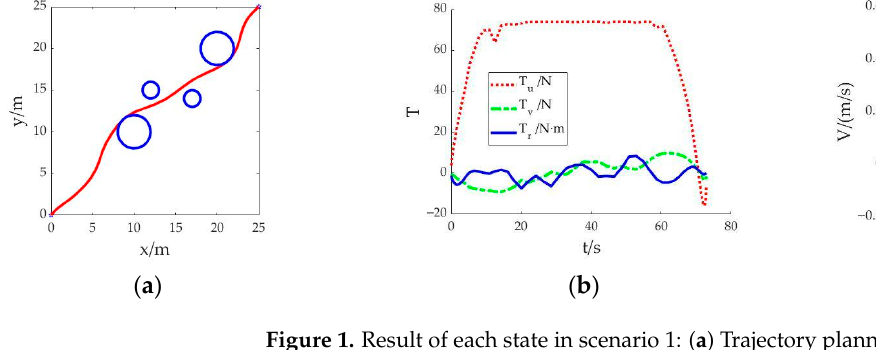
Figure 1. Result of each state in scenario 1: ( a ) Trajectory planning of the AUV; ( b ) Variation diagram of thrust; ( c ) Diagram of velocity change in x and y directions.